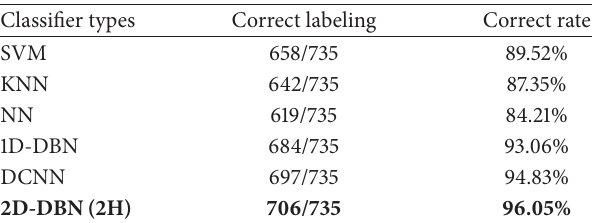
Table 2: Detection results of multiple methods.